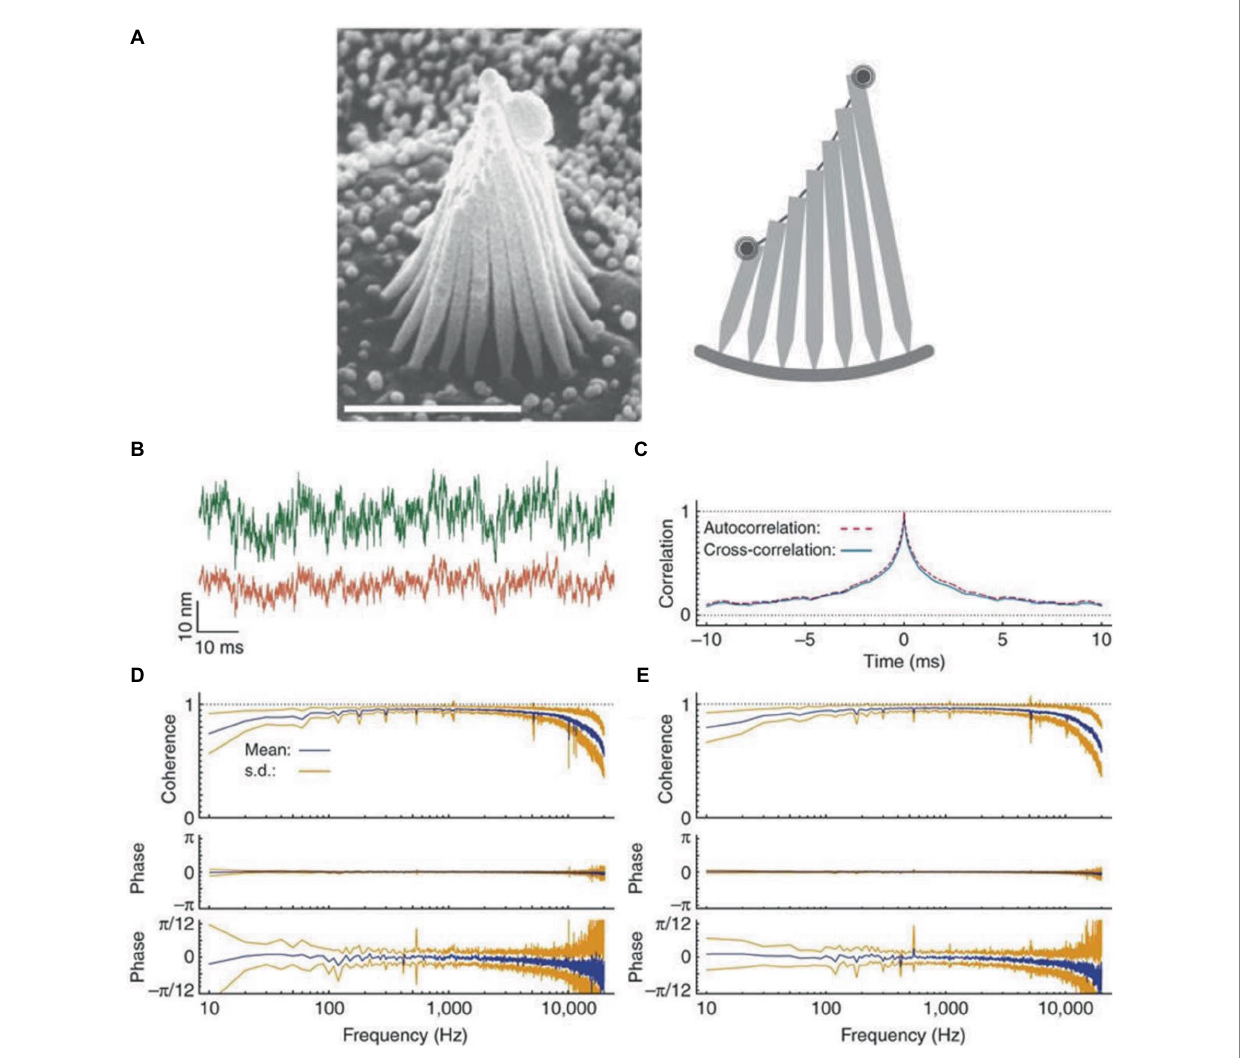
FIGURE 1 Coherent motion of stereocilia of hair cells of bullfrog’s sacculus. (A) Left: scanning electron micrograph of a hair bundle. Right: schematic diagram of a slice along the hair bundle, with the two spots representing the laser beams employed in interferometric measurements positioned on the bundle’s opposite edges. (B) When the green (top trace) and red laser beams are focused on the opposite edges of a hair bundle, the two records of thermal motion are very similar, except for different amplitudes due to different stereociliary lengths. (C) Crosscorrelation averaged over 20 records (blue line) and superimposed on the corresponding autocorrelation (red dashed line). (D) Coherency spectrum from the opposite edges of 18 hair bundles shows high values and negligible phase lag at frequencies up to 10 kHz. The phase spectrum shown at a higher magnification (bottom trace) shows a systematic deviation of the mean phase lag from zero at frequencies close to the analog filters’ cutoff, due to anti-aliasing filters. (E) For comparison, the spectrum for the beams focused on the same edge of the hair bundle is highly similar to that in panel (D) . The results in this Figure are for quiescent hair bundles, but the results for oscillating hair bundles are very similar. Reproduced with permission from Kozlov et al.